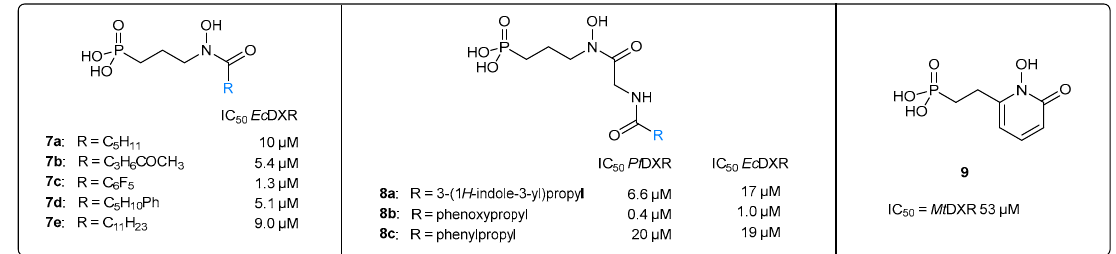
Figure 10. Structures and biological activities of compounds 7 – 9 with modified MBGs.